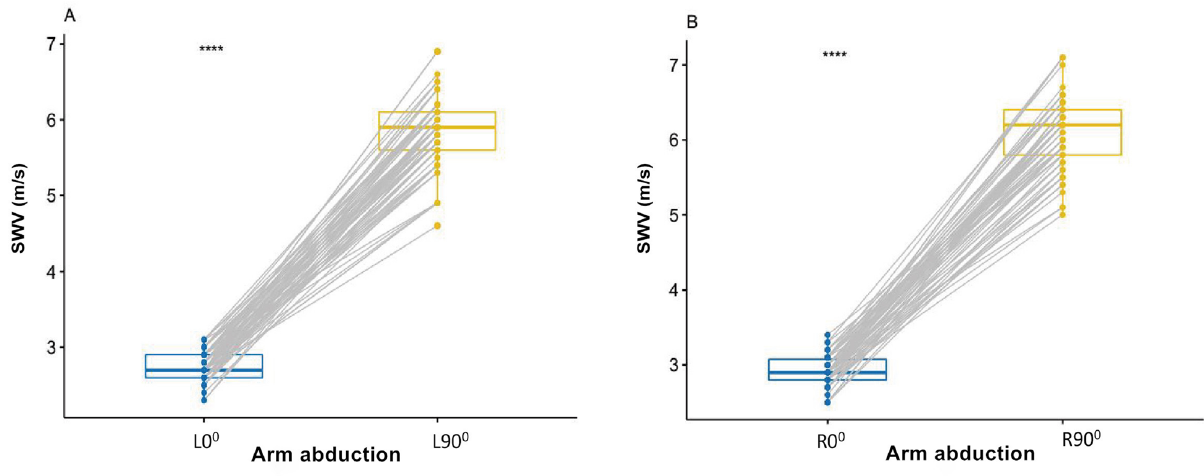
Figure 2. Box-and-whisker plots of the SWV in healthy participants using SWE between L0° and L90° ( A ), between R0° and R90° ( B ). ( A ). Difference of the SWV between L0° and L90°, ( B ) Difference of the SWV between R0° and R90°; **** p < .0001. SWV mean shear wave